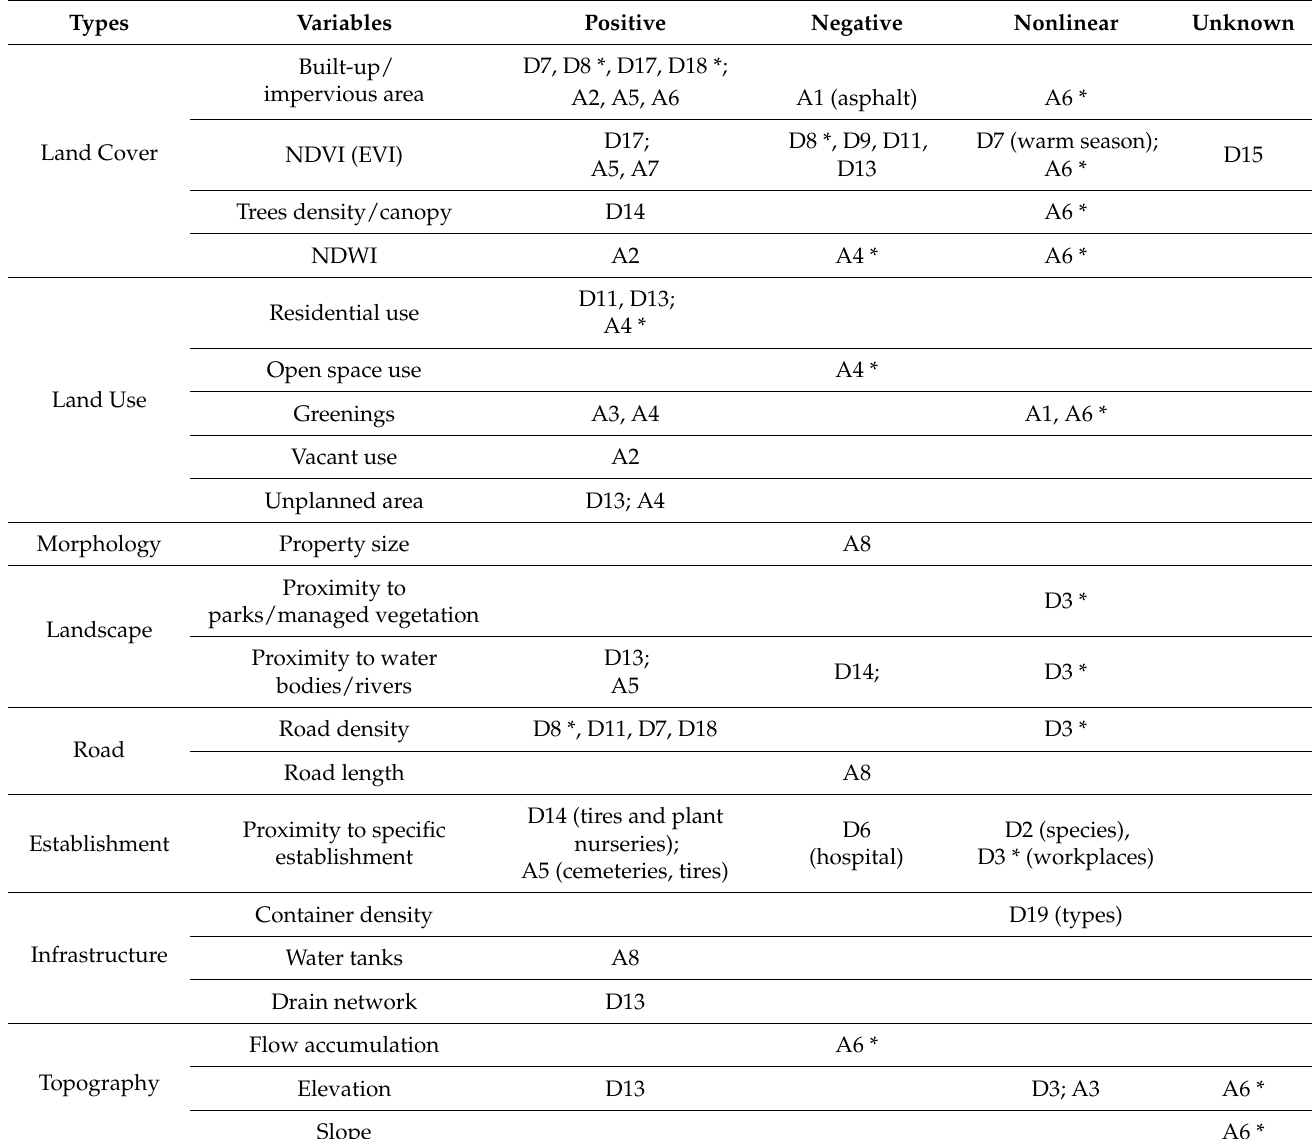
Table 4. Effect of built environmental variables on dengue-related